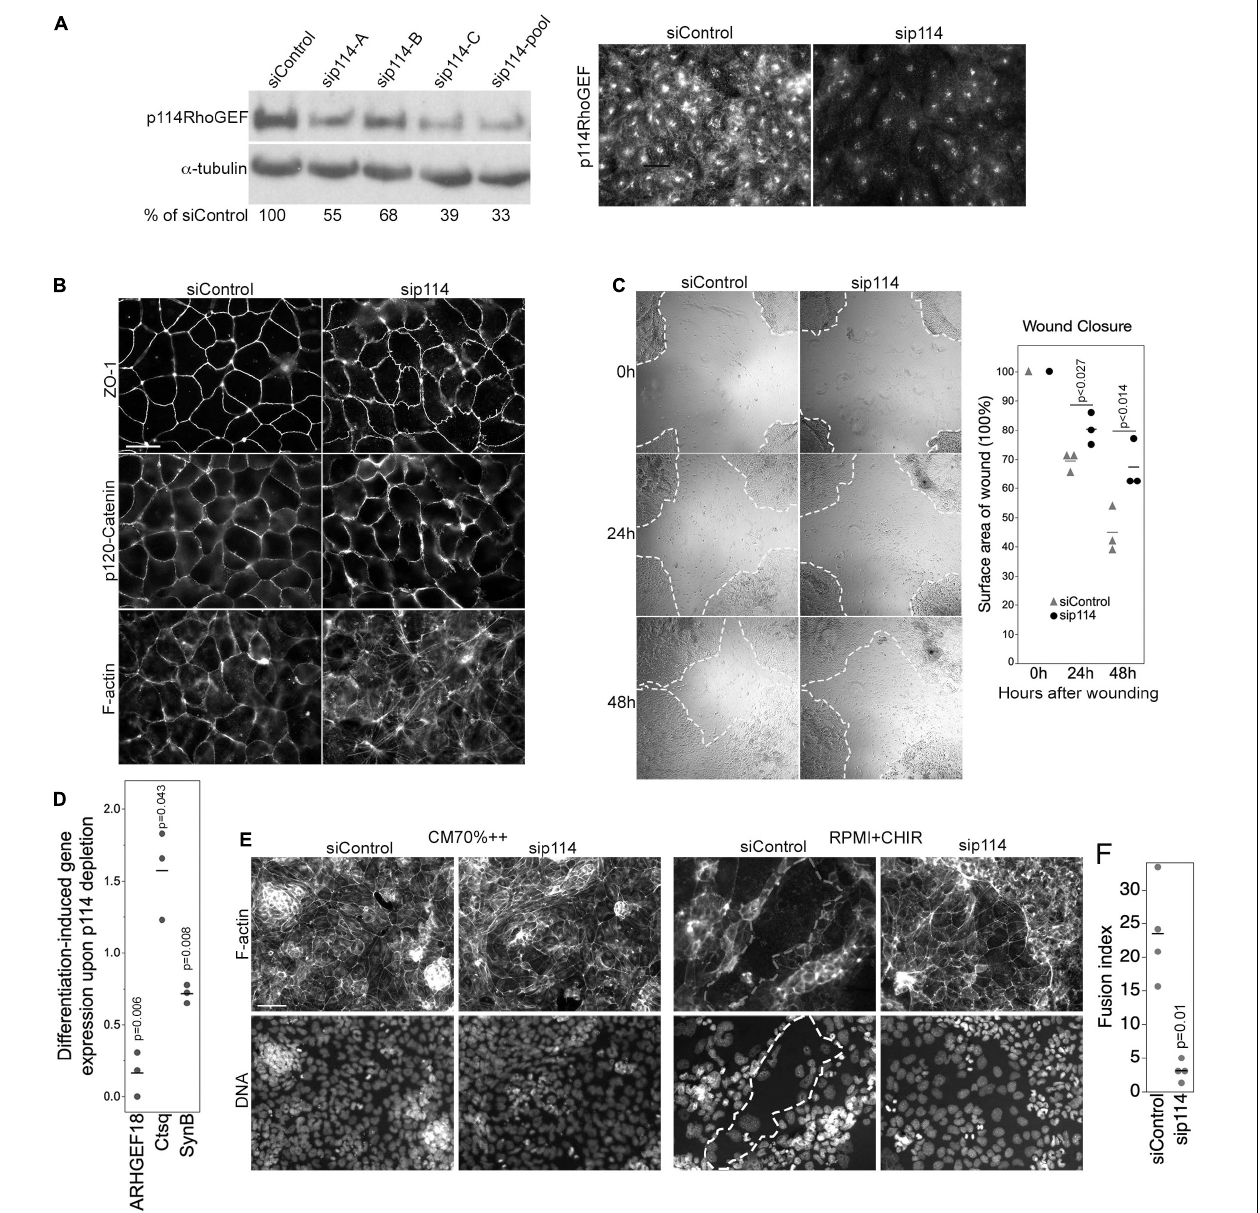
FIGURE 5 | p114RhoGEF regulates trophoblast differentiation. (A) Depletion of p114RhoGEF in siRNA-transfected TS-Rs26 cells was analyzed by immunoblotting and immunofluorescence. (B) Analysis of the tight junction protein ZO-1, the adherens junction protein p120-catenin, and F-actin in control and p114RhoGEF-targeting siRNA transfected TS-Rs26 cells by fluorescence microscopy. (C) Cell migration analyzed by scratch wound closure after 0, 24, and 48 h in TS-Rs26 cells transfected with siRNAs as indicated. Percentage of wound closure was calculated at each time point and plotted from three independent experiments. Shown are data points, means and p-values derived from t -tests. (D) Expression of trophoblast lineage markers in cells kept in standard maintenance medium (CM70% + +) or upon induction of differentiation with RPMI containing the GSK3 β -inhibitor CHIR was analyzed by RT-qPCR. Shown are data points of three independent experiments normalized to respective control values, means and p -values derived from t -tests. Note, depletion of p114RhoGEF attenuates induction of the syncytiotrophoblast marker SynB. (E,F) Cells cultures as in panel (D) were analyzed by fluorescence microscopy upon labeling F-actin and DNA. An area occupied by a large fused cell is demarked with a dashed line. The graph shows a quantification of the fusion index from four separate experiments ( p -value based on t -test). Note, fusion was inhibited by p114RhoGEF depletion. Bars: (A,B) , 40 µ m; (C) , 1 mm; (E) , 100 µ